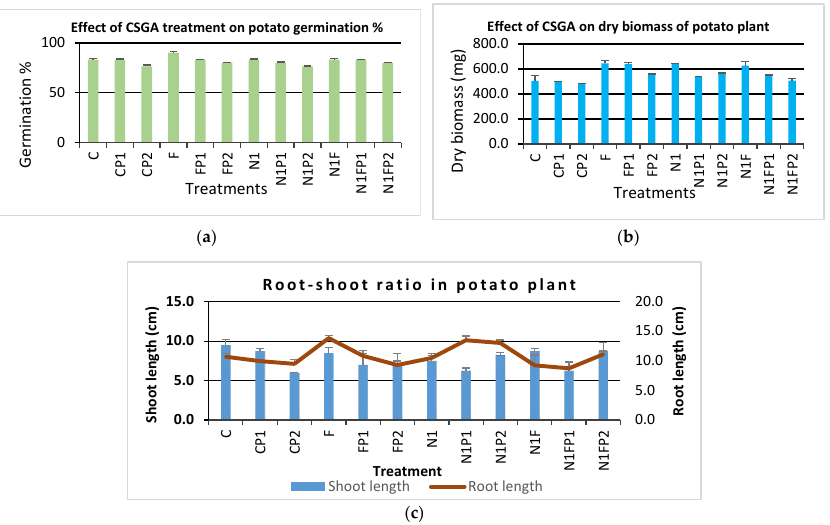
Figure 8. Effects of NCs on potato plant development characteristics: ( a ) germination percent; ( b ) dry biomass per plant; ( c ) root-shoot ratio; where C — Control, CP1 — pathogen P1, F — commercial fungicide, FP1 — commercial fungicide + P1, N1 — blank NCs, N1P1 — pathogen P1 + blank NCs, N1F — mancozeb-loaded NCs, N1FP1 — loaded NCs + P1; CP2 — pathogen P2, FP2 — fungicide + P2, N1P2 — blank NCs + P2, N1FP2 — mancozeb-loaded NCs + P2; P1 stands for A. solani and P2 for S. sclerotiorum .